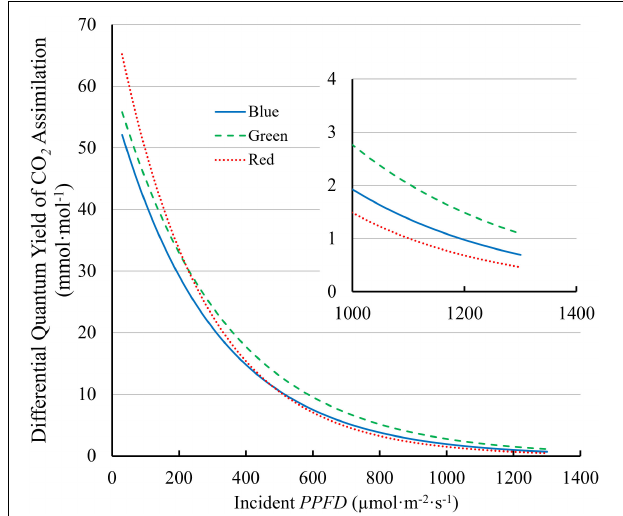
FIGURE 7 | The differential quantum yield of CO 2 assimilation ( differential QY ) of “Green Towers” lettuce under blue, green, and red LED light as a function of the PPFD . The differential QY is the increase in net assimilation per unit additional PPFD and was calculated as the first derivate of the light response curves ( Figure 3 ). The insert shows the differential quantum yield plotted at PPFDs of 1,000–1,300 µ mol m − 2 s − 1 s to better show differences at high PPFD (note the different y -axis